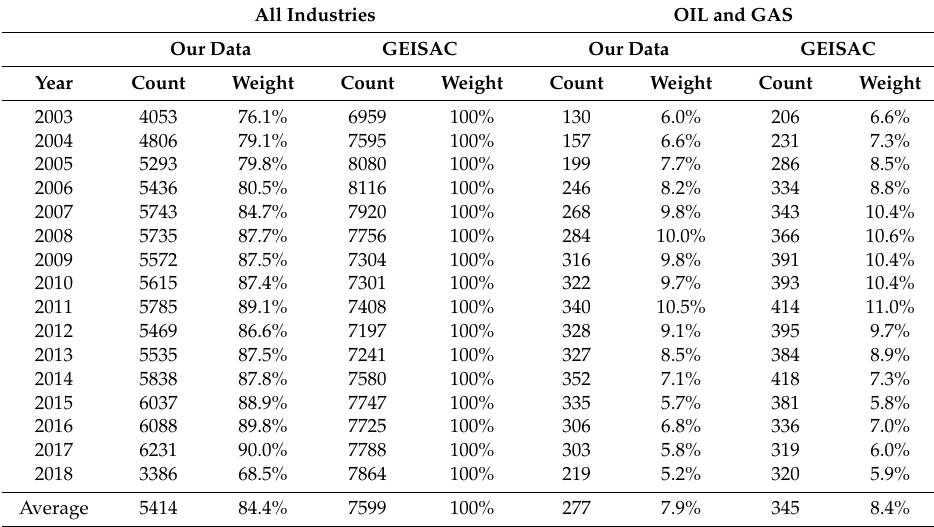
companies in the FTSE GEISAC are shown for comparison.